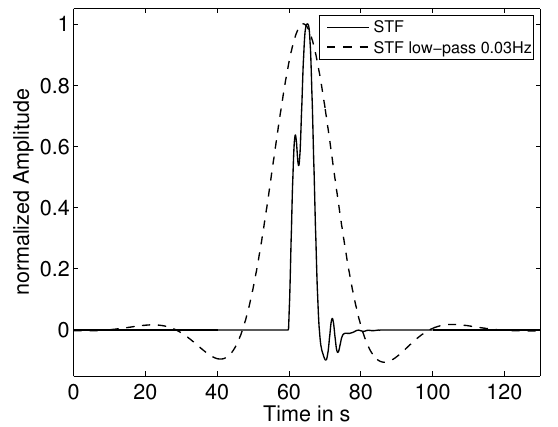
Fig. 6. Inverted source time function of the 2009 L’Aquila event unfiltered (solid) and filtered to periods of T ≥ 33s